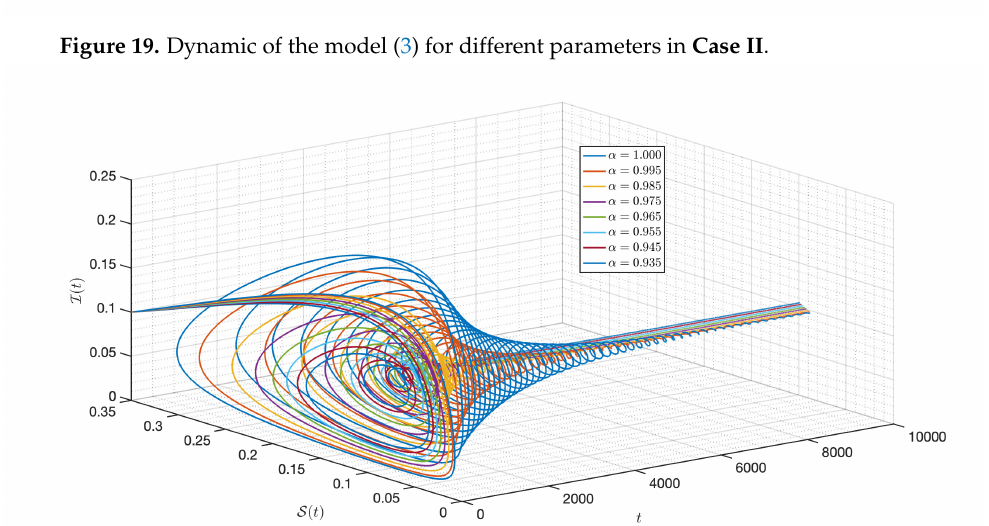
Figure 20. Dynamic of the model (3) for different parameters in Case II